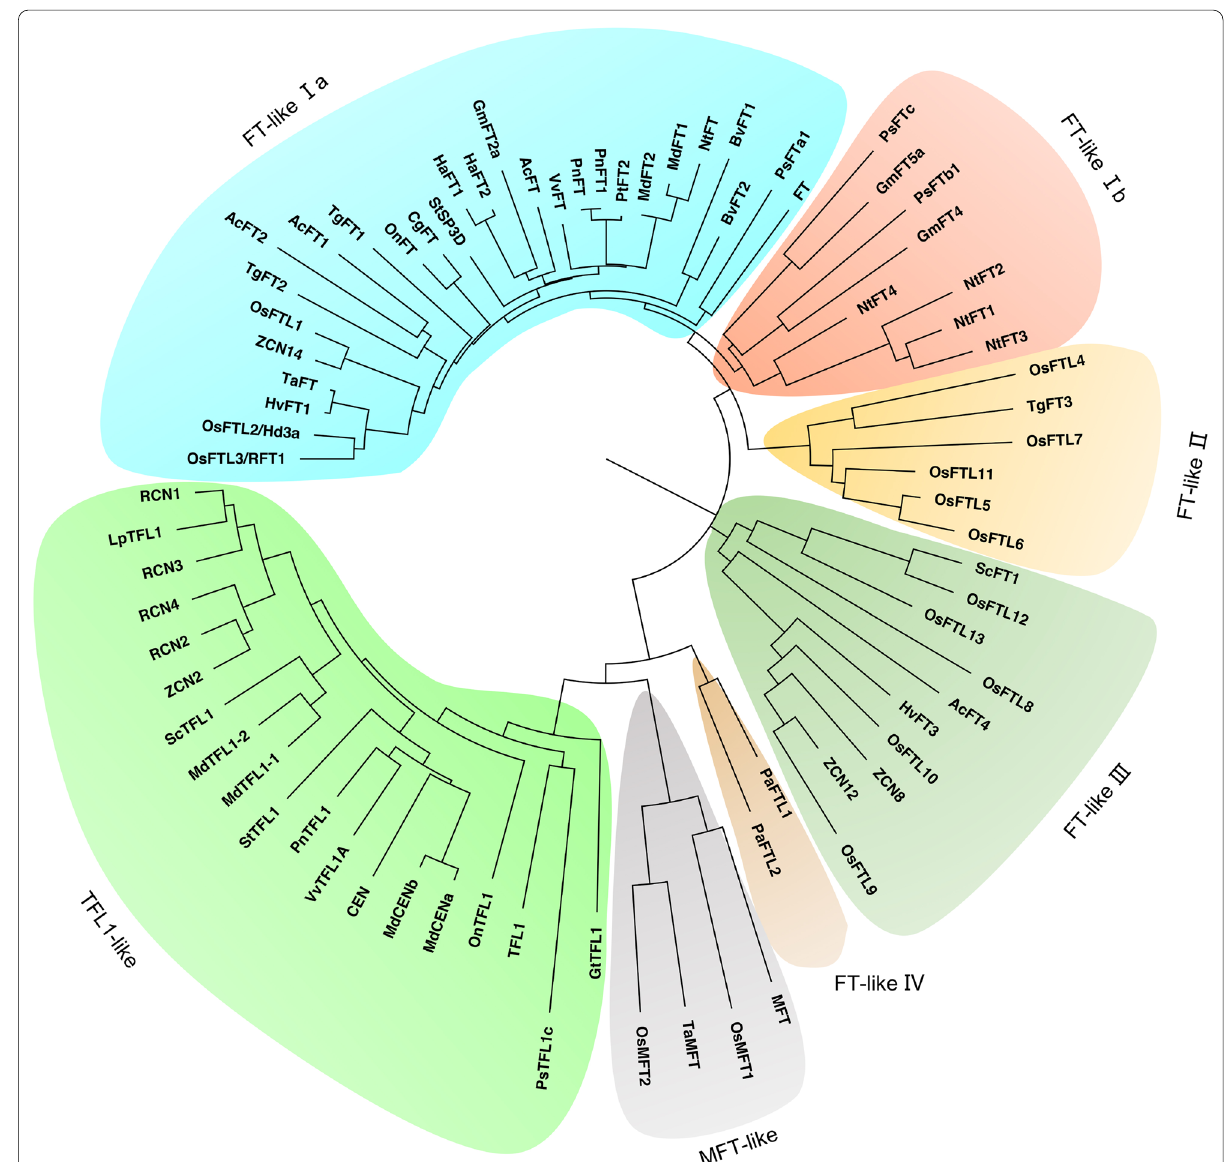
Fig. 1 Phylogenetic analysis of PEBP family members in Oryza sativa and other plant species. Sequence alignment of OsFTL4 and other FT(-like) and TFL1(-like) proteins in Arabidopsis thaliana , Oryza sativa , Glycine max , Nicotiana tabacum , Helianthus annuus , Beta vulgaris , Tulipa gesneriana , Malus domestica , Hordeum vulgare , Narcissus tazetta , Gentia natriflora , Oncidium ‘Gower Ramsey’, Vitis vinifera , Populus nigra , Zea mays , Picea abies ,